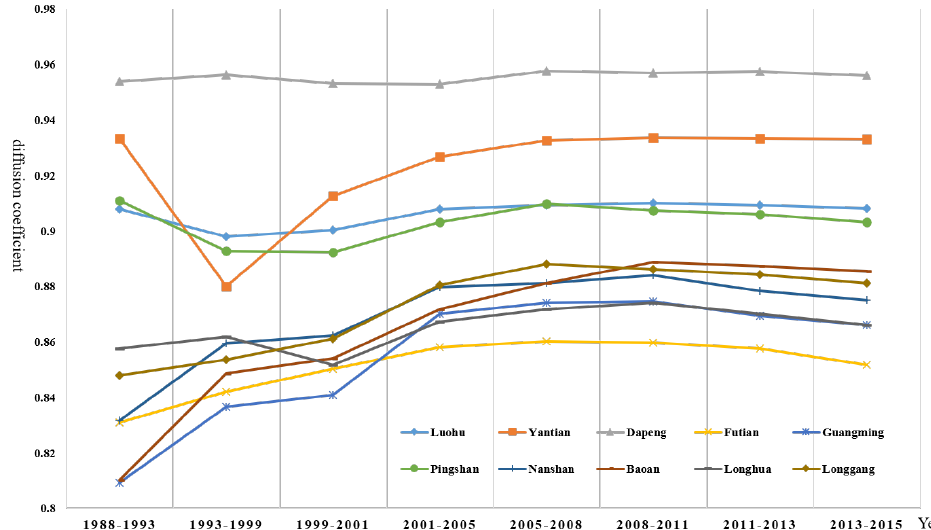
Figure 5. The changes in the diffusion coefficient for the built-up areas in Shenzhen. We mapped the spatial location of each district in Shenzhen to obtain Figure